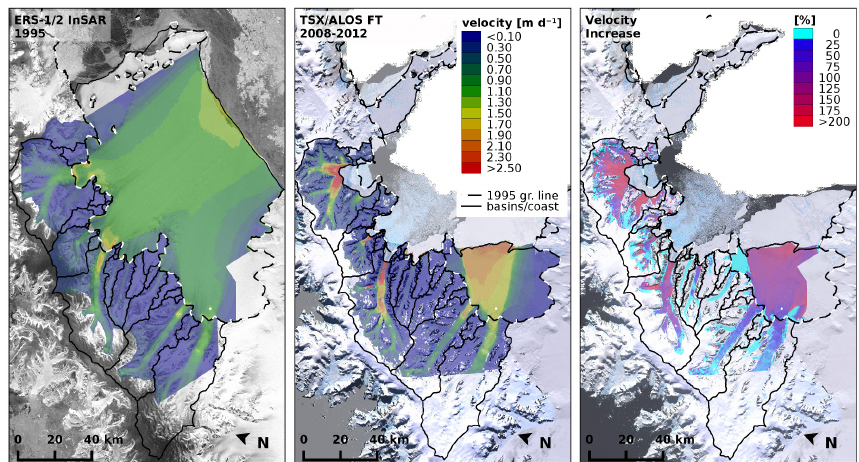
Figure 2. Maps of glacier surface velocity in the Larsen B region. Left: based on ERS InSAR data of October/November 1995 (background RAMP mosaic; Jezek et al., 2013). Center: based on TSX and PALSAR offset tracking 2008–2012. Right: Velocity increase 2008–2012 vs. 1995. Background LIMA mosaic (Bindschadler et al., 2008). The dashed line shows the position of the 1995 grounding line. Front positions are from October 1995 (left) and January 2012 (center and